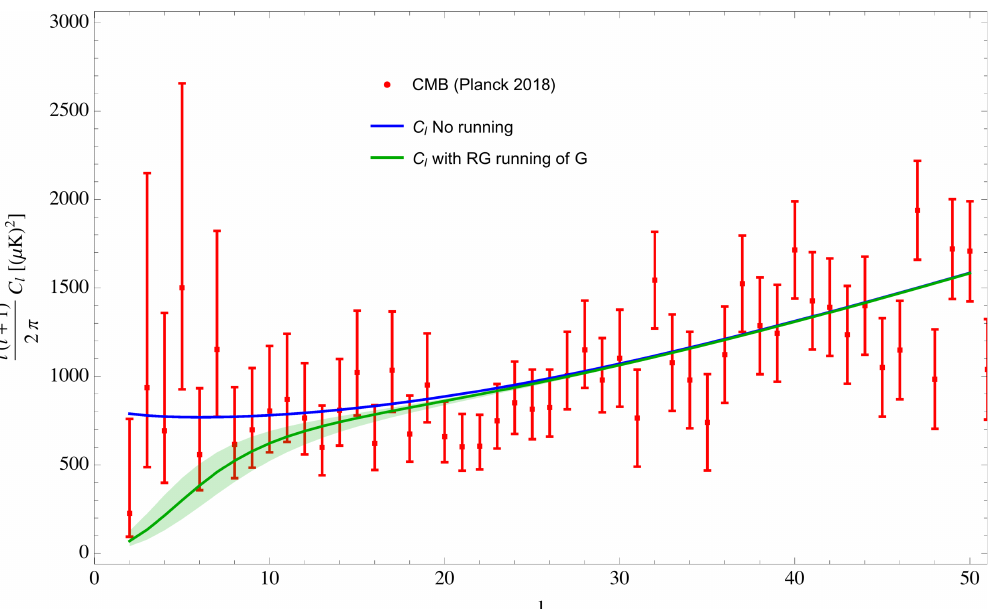
Figure 6. Plot of the angular power spectrum coefficients l ( l + 1 ) C l /2 π . The upper (blue) curve shows the quantum gravity prediction of the angular CMB power spectrum C l ’s as obtained from the matter power spectrum P ( k ) (and thus with scaling exponent ν =1/3), without any IR regulation effect from ξ , and without the RG running of Newton’s constant G . The bottom (green) curve shows the combined quantum gravity effect now with IR regulation and the lattice RG running of Newton’s constant G , with the original lattice quantum amplitude 2 c 0 = 16.04. The upper and lower bands on the bottom curve represent a factor of 2 variance on the quantum amplitude c 0 , i.e., 2 c 0 = ( 8.02,32.08 )